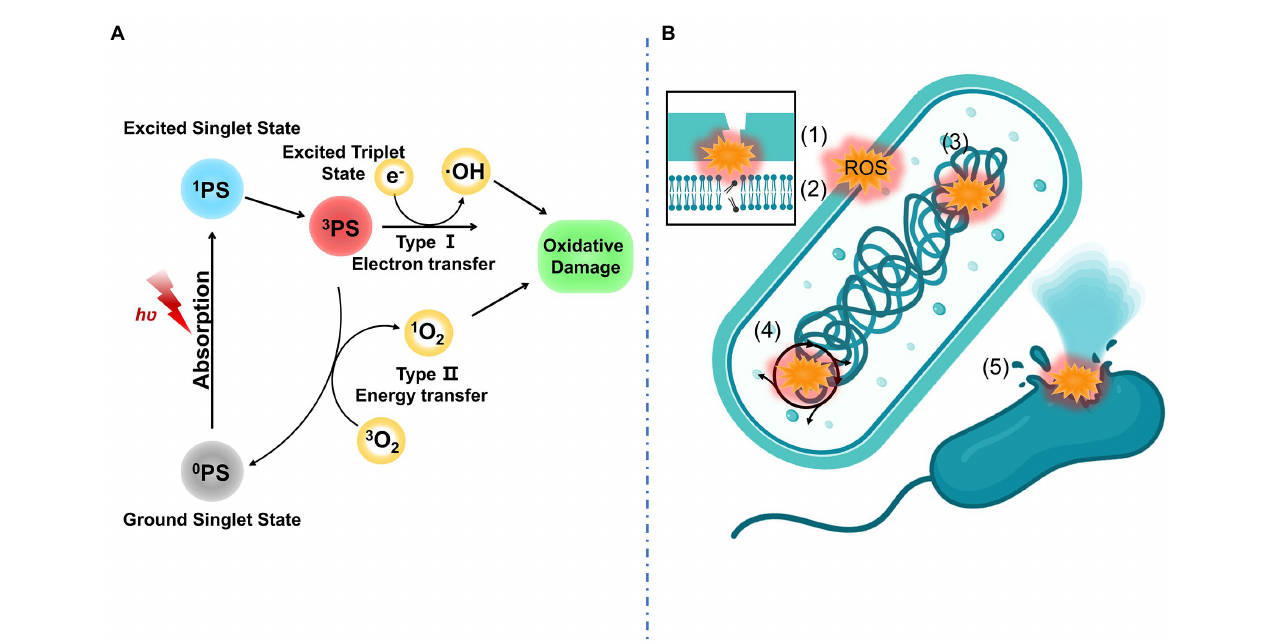
FIGURE 1 (A) PDT mechanism including type I mechanism (electron transfer) and type II mechanism (energy transfer); (B) Antibacterial mechanism of aPDT including (1) altered outer membrane permeability, (2) oxidation of lipids, (3) protein or DNA damage, (4) interfere with bacterial metabolism, and (5) irreversible bacterial destruction.